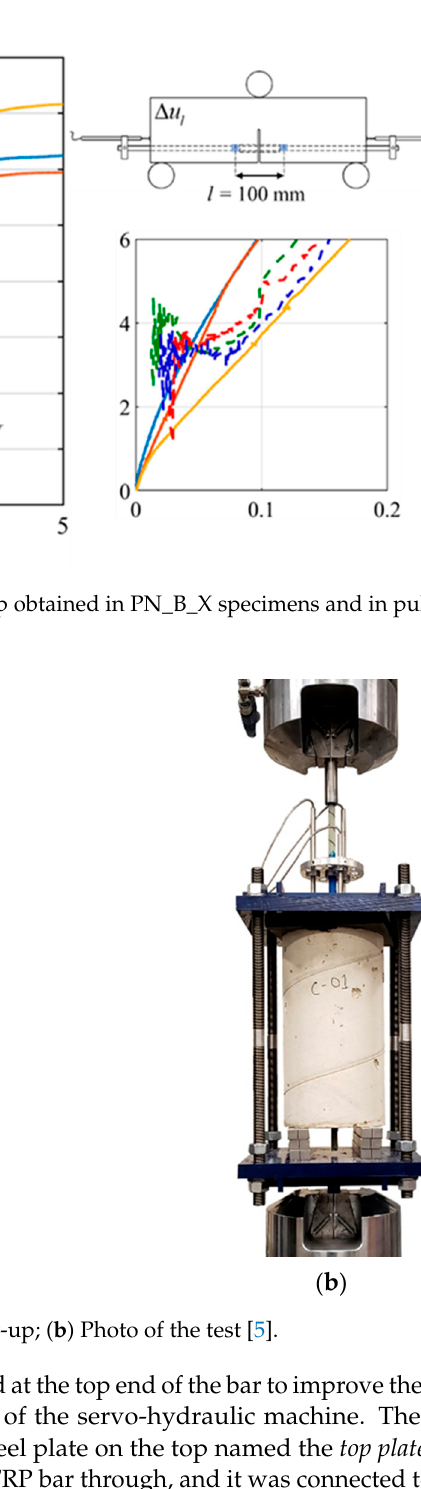
(7) where q and r are the lengths of the compressive and tensile region, respectively, for the uncracked concrete block, and w is the distance from the N.A. to the centroid of the GFRP bar. k and h are the lengths of the tensile regions corresponding to the forces T 2 and T 3 , and j is the distance of T 2 to the beginning of the FPZ. The slip of the GFRP bar ( g ) at the beginning of the bonded area was determined from DIC analysis. The difference of the horizontal displacements between the two points on each side of the notch corresponding to the beginning of the bonded areas was named Δ u l and was obtained from DIC analysis. Two squares (10 mm side) on each side of the notch where the bond breaker ended were used to average the horizontal displacements. The difference of the averages of the dis- placements corresponded to Δ u l . The slip g was then obtained by subtracting the elastic deformation of the bar from Δ u l and assuming an equal slip on each side of the notch: 2 bar l (8) As noted above, l is the length of the unbonded length due to the presence of the bond breakers. Figure 15 shows the plot of the force in the GFRP bar ( P bar ) versus the slip g for the three PN_B_X specimens for which DIC analysis was available. Figure 15 includes the applied load P versus the loaded end slip g from three pull-out tests of the same GFRP bar embedded in concrete cylinders. These plots refer to an experimental campaign conducted